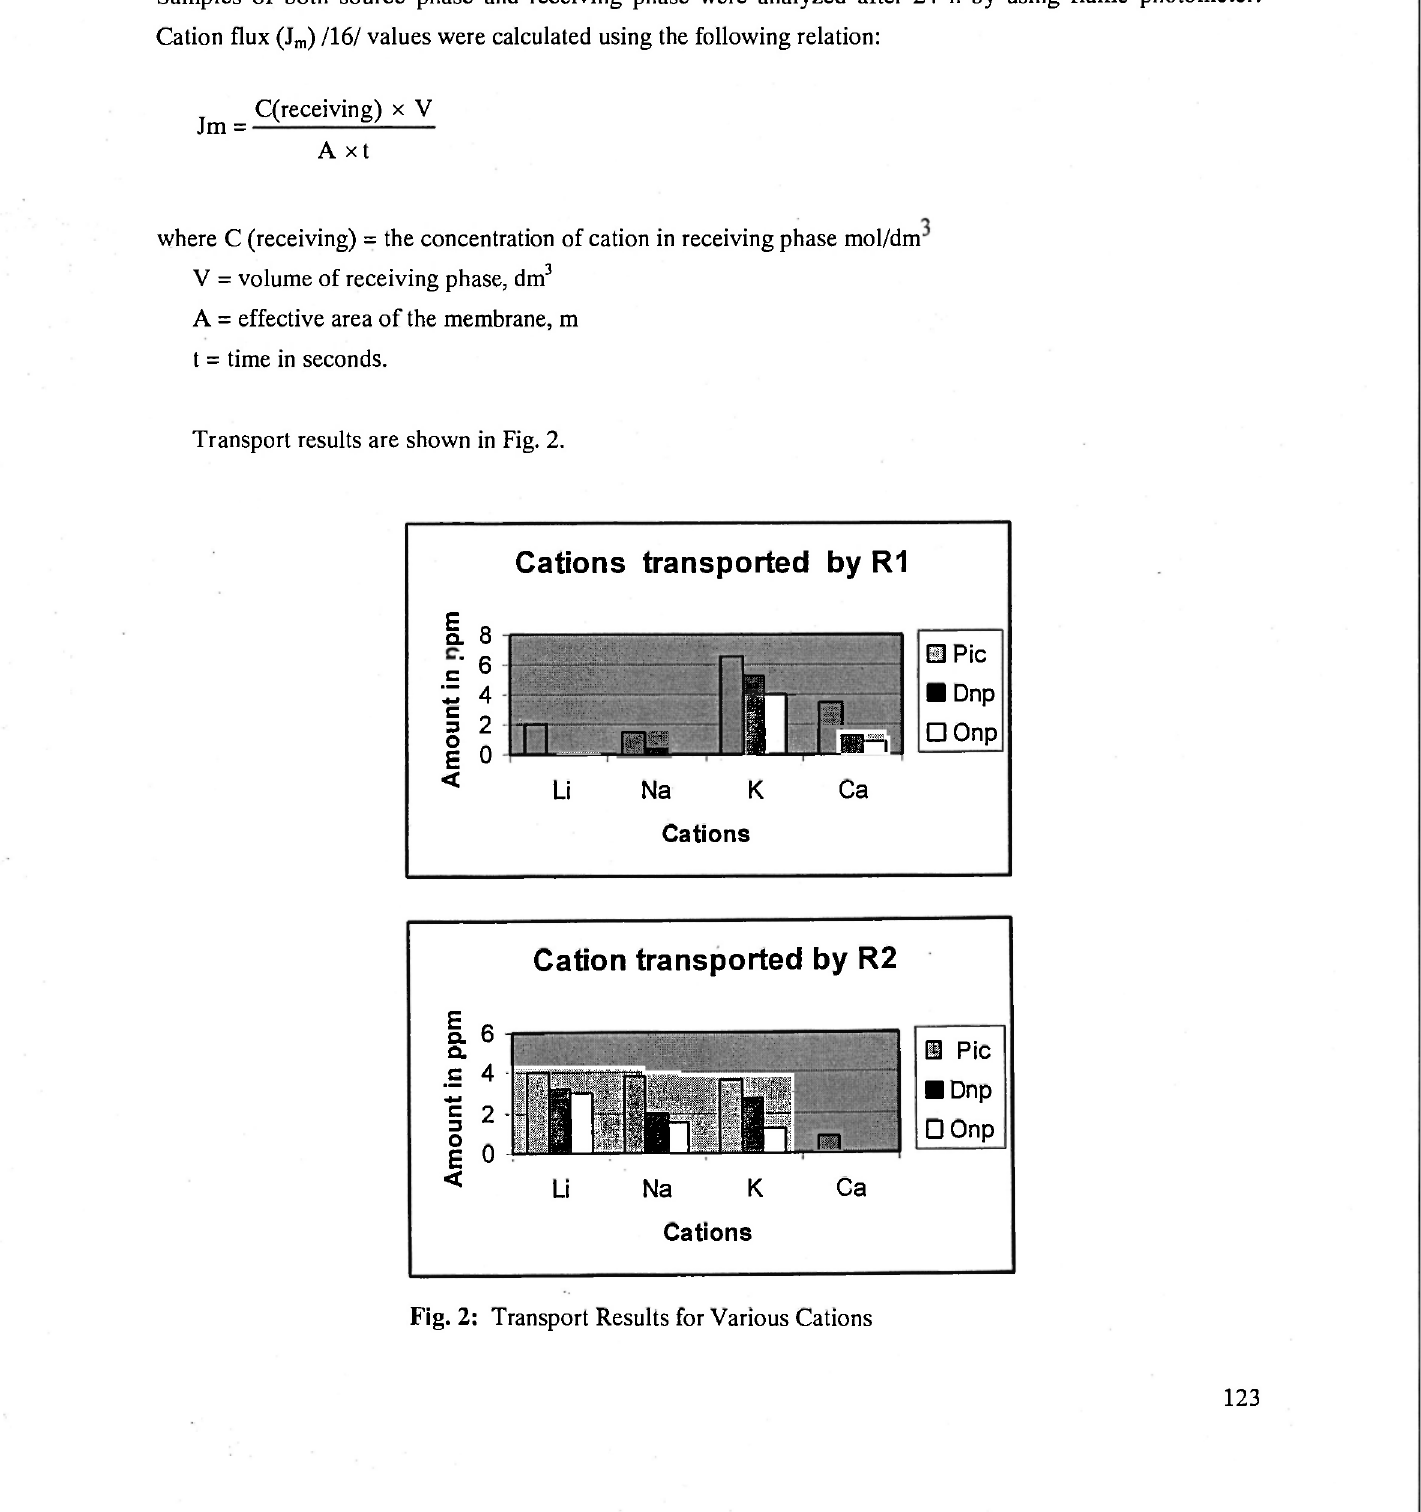
Fig. 2: Transport Results for Various